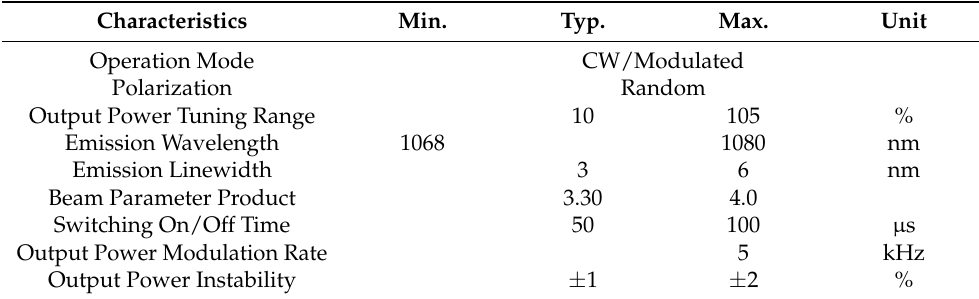
Table 1. Optical characteristics of laser resonator. Characteristics Min.